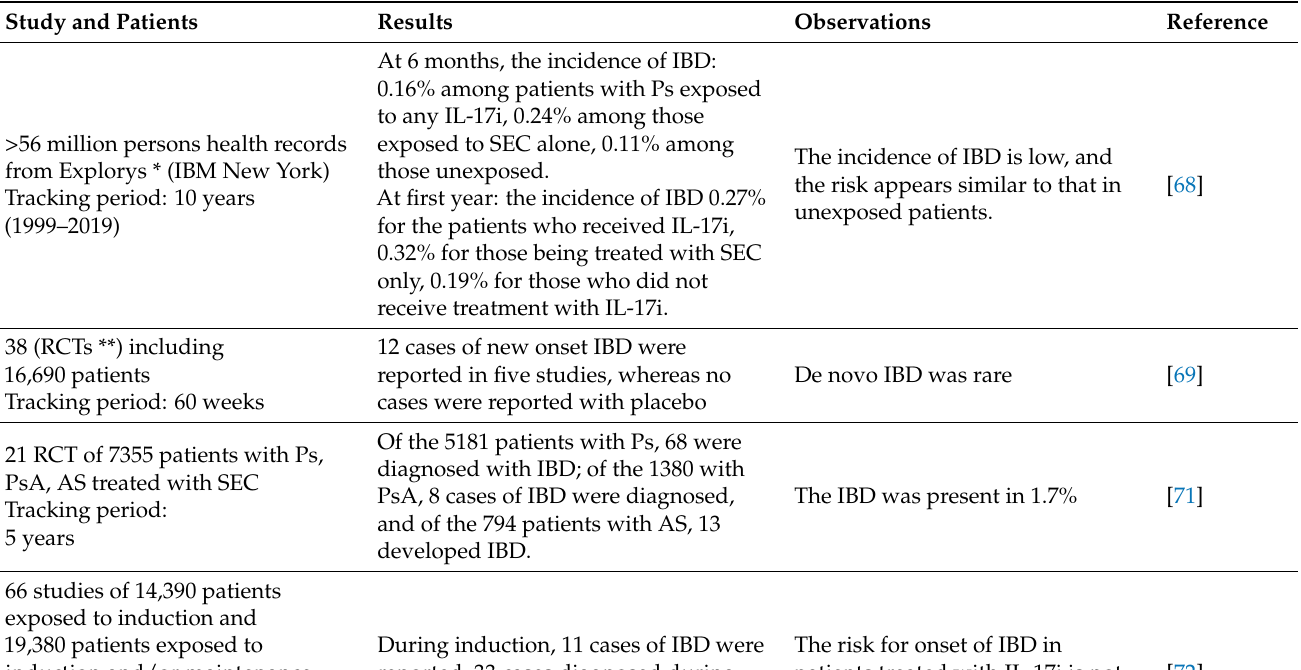
Table 2. Meta analysis studies and multiple case report about incidence and adverse effects of